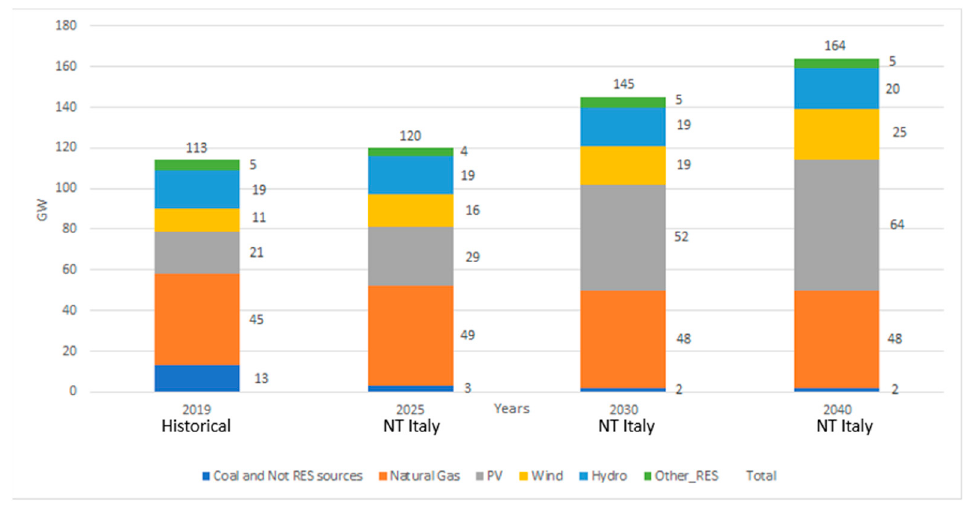
Figure 9. Historical and forecast of the Italian installed capacity per fonts by NT Italy.